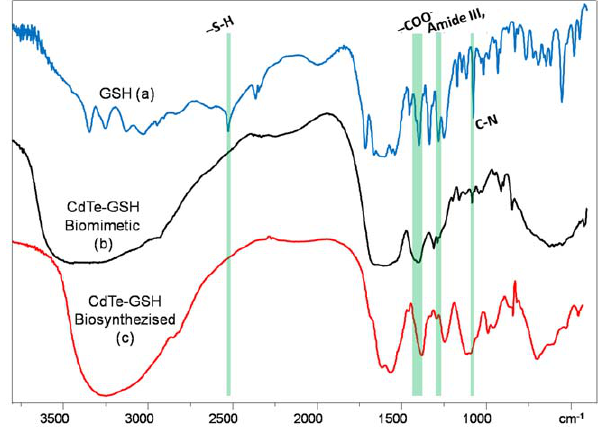
Figure 7. FTIR spectroscopy of GSH (A), chemically synthesized (B) and biosynthesized (C) CdTe-GSH QDs. Biological CdTe NPs where purified as described in Methods and chemical, biocompatible CdTe QDs where synthesized as described [19]. FTIR spectroscopy spectra were recorded and compared with a GSH standard.